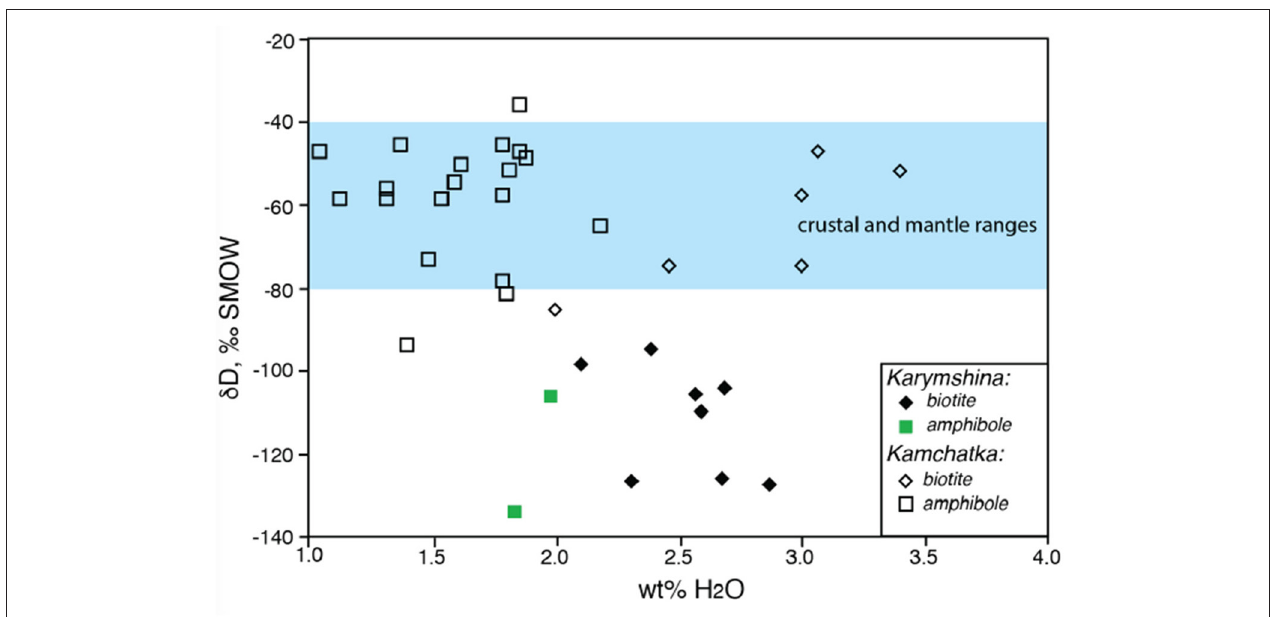
FIGURE 6 | δ D and H 2 O in Karymshina biotites and amphiboles in comparison to other published data for Kamchatka (Taran et al., 1997; Shipley, 2011). Notice lower δ D range for Karymshina magmas but comparable H 2 O content suggesting lack of significant chloritization of analyzed minerals. Overall low- δ D values (lower than typical crustal and mantle values) would agree with assimilation of hydrothermally-altered rocks, possibly altered by low δ D and low δ 18 O meteoric waters during Pleistocene